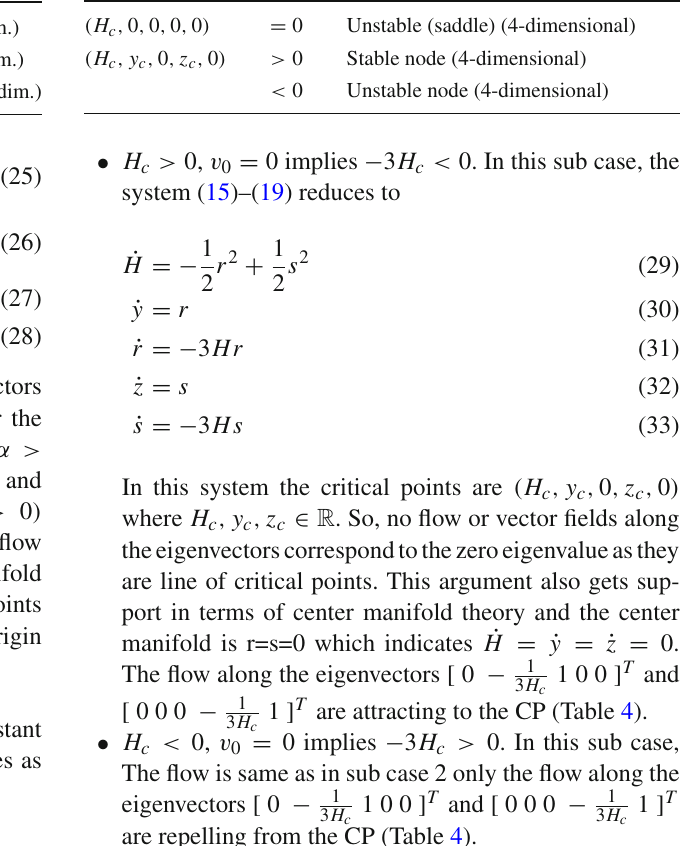
Table 3 Stability analysis (for v 0 (cid:3)= 0, 9 H 2 c − 8 v 0 > 0) Critical points α , β ( (cid:3)= 0)